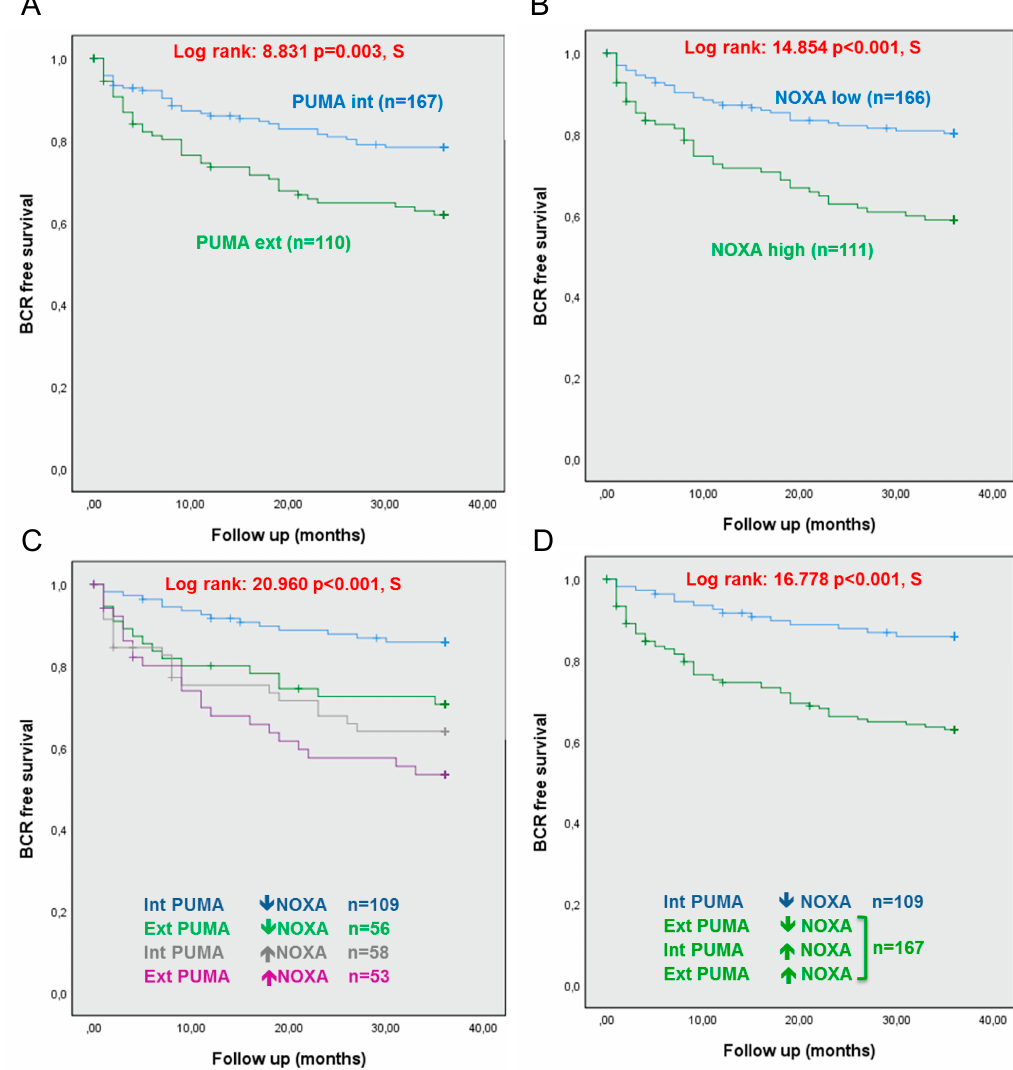
Figure 3. PUMA or NOXA expression in benign epithelium, alone or in combination, are associated with increased BCR risk at 3 years. Kaplan–Meir plots showing that ( A ) extreme expression of PUMA was associated to an increased risk of BCR at 3 years, ( B ) high NOXA expression was associated to an increased risk of BCR at 3 years, ( C ) combined expression of PUMA and NOXA in four groups was associated with BCR in PC patients at 3 years and ( D ) combined expression of PUMA and NOXA in two groups was associated with BCR in PC patients at 3 years. PUMA extreme (Ext) expression was < 1st quintile and ≥ 5th quintile of MFI; PUMA intermediate (Int) expression was between ≥ 1st quintile and < 5th quintile of MFI. NOXA high expression was ≥ 4th quintile and low expression was < 4th quintile of MFI. A p -value < 0.05 was considered statistically significant (S).